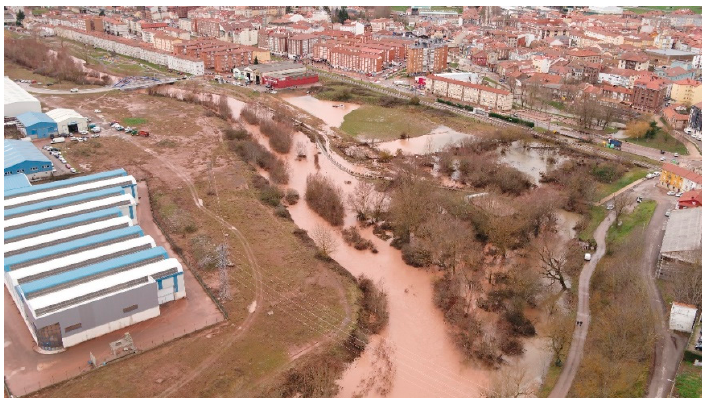
Figure 1. Reinosa (Cantabria, Spain). 20th December 2019.